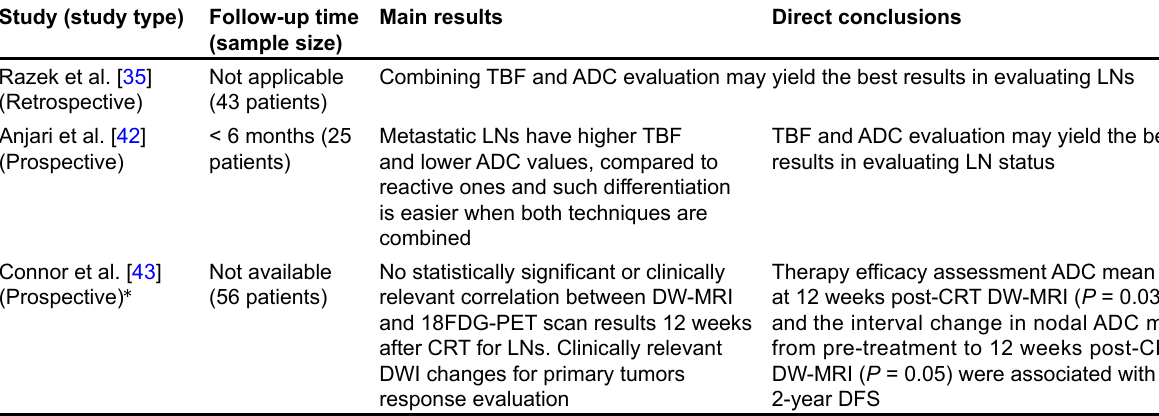
Table 2. Insight into the main retrieved findings ( continued